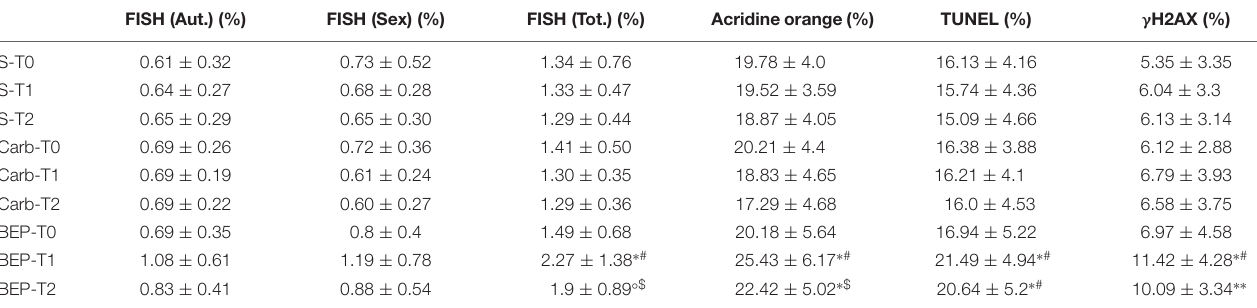
TABLE 2 | Sperm aneuploidies and nuclear status observed in different groups at baseline, T1 and T2. FISH (Aut.) (%) FISH (Sex) (%) FISH (Tot.) (%)